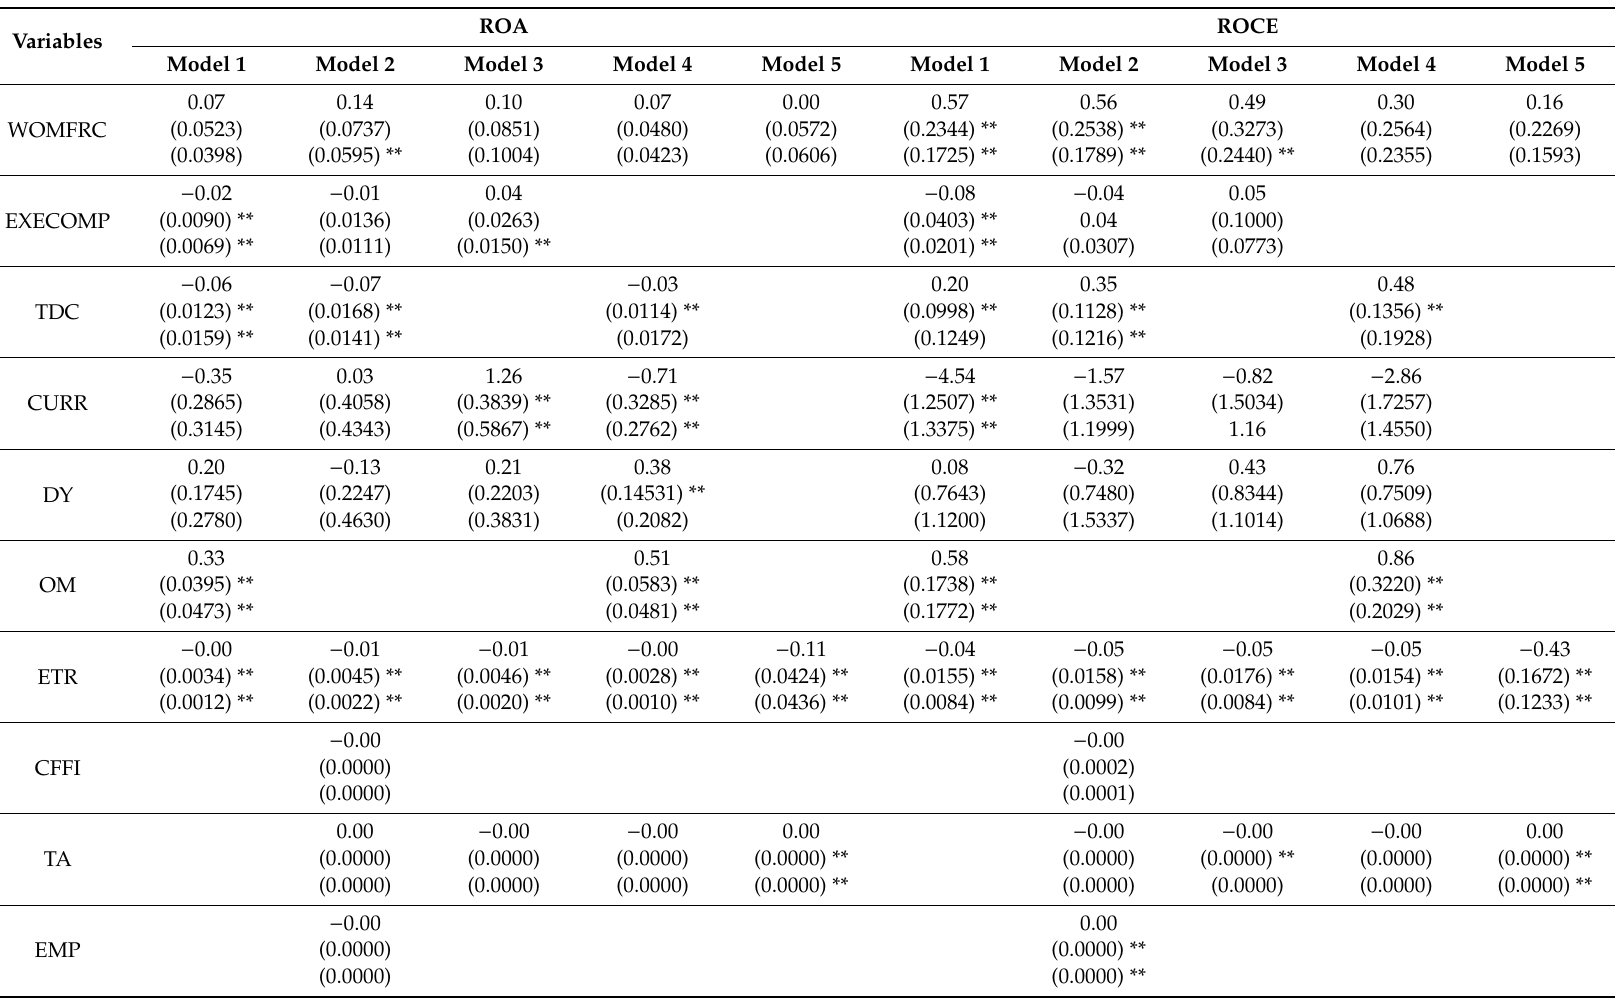
Table 7. The outcomes of panel data pooled regression models regarding the influence of water, waste, and energy consumption, alongside firm and corporate governance-specific variables, on return on assets and return on common